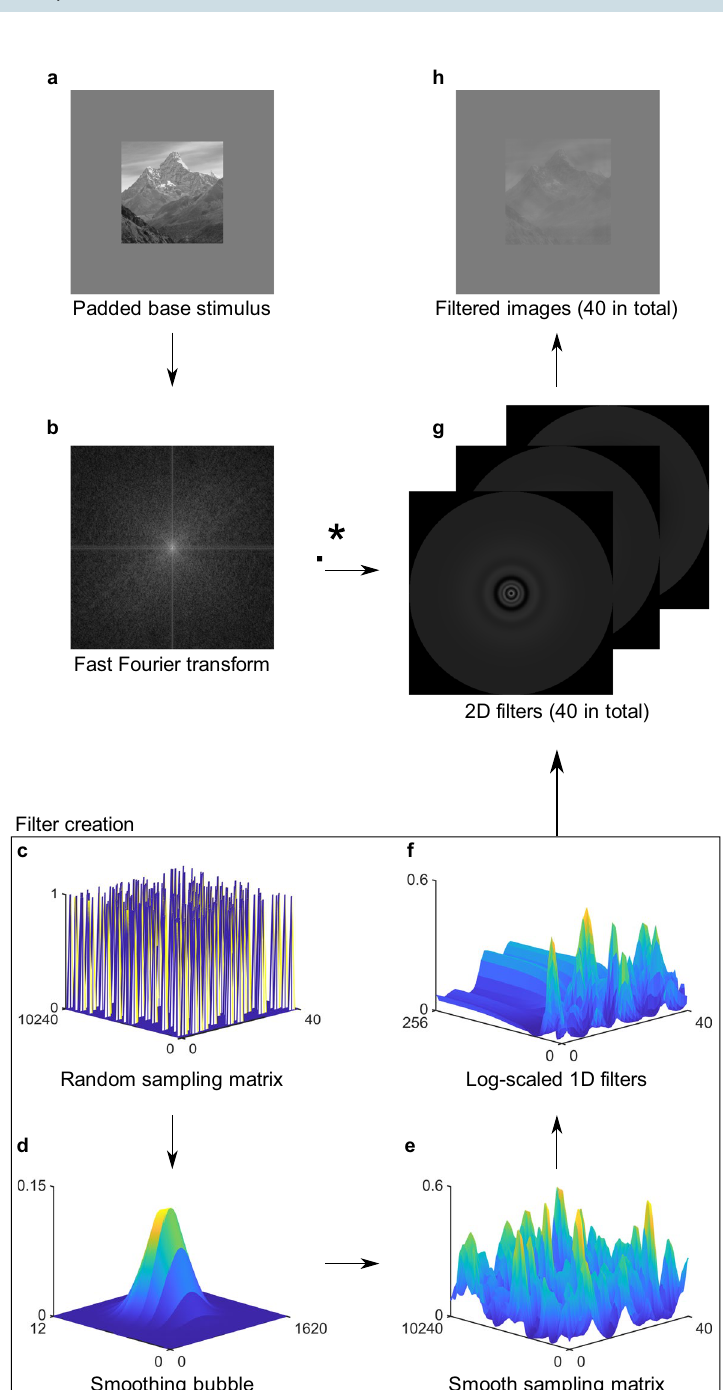
Figure 2. Filtering of stimuli using the SF Bubbles technique (see text for details). ( a ) Padded base stimulus. ( b ) Amplitude spectrum of the padded base stimulus after Fast Fourier transform. ( c ) Random binary sampling matrix. ( d ) Gaussian SF smoothing bubble. ( e ) Smoothed sampling matrix after convolution of the binary sampling matrix with the SF bubble. ( f ) Array of 1D filters after log-scaling of the smooth sampling matrix in the SF dimension. ( g ) 2D filters that are dot-multiplied with the amplitude spectrum of the base stimulus. ( h ) Filtered stimuli after the inverse